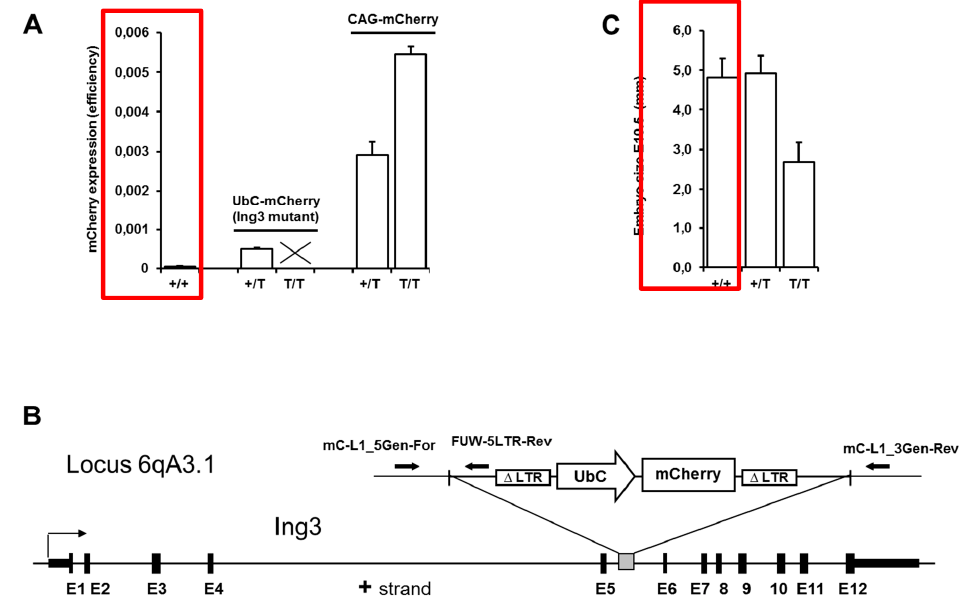
Figure 1. Quantification of overall fluorescence, schematic view of UbC-mCherry integration site, and embryo size. ( A ) Overall fluorescence of wild type ( +/+ ; n = 4) and hemizygous ( +/ T; n = 8) UbC-mCherry mice, and hemizygous ( +/ T; n = 4) and homozygous (T / T; n = 4) CAG-mCherry mice. ( B ) Integration site of the UbC-mCherry cassette at 6qA3.1 disrupting the Ing3 locus. ( C ) Embryo size of wild type ( +/+ ; n = 9), heterozygous ( +/ T; n = 19), and homozygous (T / T; n = 8) Ing3 insertional mutants at E10.5. Table 1. Genotypes of Ubc-mCherry born mice, female of male ratio, and genotype of blastocysts from hemizygous × hemizygous matings. Genotype +/+ +/T T/T